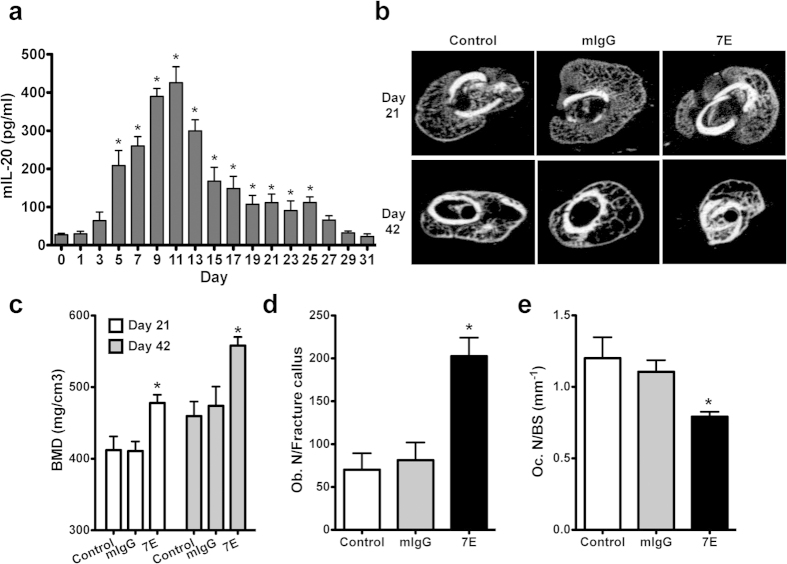
IL-20 was involved in osteoblastogenesis during bone fracture healing in vivo.(a) Levels of IL-20 in serum from mice with bone fracture were analyzed at the indicated time during fracture healing. Values are means ± SD of 6 mice. Data are representative of three independent experiments. *P < 0.05 versus 0 day post-fracture. (b) Representative figures of micro-CT analyses of the fracture callus of mice 21 and 42 days post-fracture, followed by no treatment (Control), 3 mg mIgG/kg/3 d treatment, and 3 mg 7E/kg/3 d treatment (n = 8/group). Images of these individual slices were taken from the central region of each callus. Data are representative of three independent experiments. (c) BMD at the fracture callus was assessed using micro-CT scans 21 and 42 days post-fracture (n = 8/group). Values are means ± SD. Data are representative of three independent experiments. *P < 0.05 versus mIgG controls. (d) ALP staining analysis and quantification of the number of osteoblasts in fracture callus 21 days post-fracture (n = 8/group). Values are means ± SD of 3 frozen sections. Data are representative of three independent experiments. *P < 0.05 versus mIgG controls. (e) TRAP staining analysis and quantification of the number of osteoclasts in bone surface 21 days post-fracture (n = 8/group). Values are means ± SD of 3 frozen sections. Data are representative of three independent experiments. *P < 0.05 versus mIgG controls.